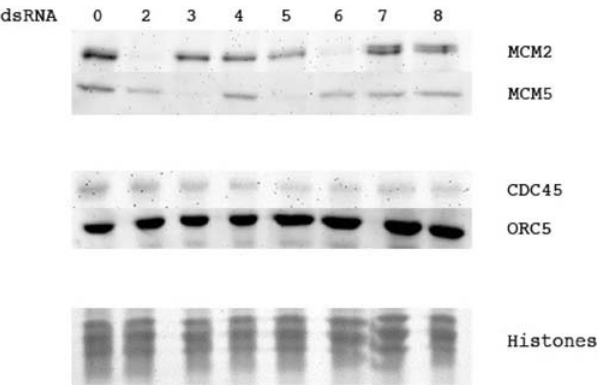
Figure 3. Immunoblot to show the effect of MCM depletions on the levels of MCM2, MCM5 ORC5 and CDC45 bound to chromatin. Coomassie stained histones are included as a loading control. The amount of each protein was compared to the histones using Alpha Innotech imager software. Horizontal numbers show the MCM protein targeted by RNAi. Several repetitions of this experiment were performed and this represents 1 complete data set.